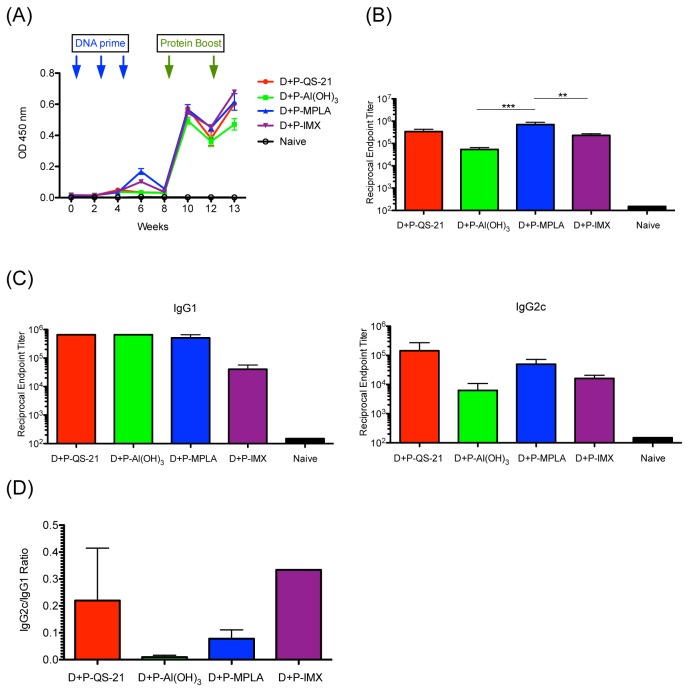
HIV-1 gp120-specific IgG response in C57Bl/6 wild type mice immunized with DP6-001 vaccine with different adjuvants.Total gp120-specific IgG was measured by ELISA in sera collected 7 days after final protein boost, in week 13. Protein boosts were formulated with QS-21 (red), Al(OH)3 (green), MPLA (blue), or ISCOMATRIX™ adjuvant (IMX) (purple). Naïve mice (black) received ‘mock’ saline injections in lieu of immunization. (A) Temporal gp120-specific IgG response was determined by ELISA using pooled sera samples from each group collected at two-week intervals. (B) gp120-specific endpoint IgG titer in was determined by ELISA using individual serum samples collected in week 13. (C) Endpoint IgG isotype profiles were determined by ELISA using individual serum samples collected in week 13. (D) Th1/Th2 ratio of IgG isotype responses was determined by comparing IgG2c/IgG1 ratio. Statistical significance was determined by one-way ANOVA and Tukey post-test (*: p < .05, **: p < .01, ***: p < .001).